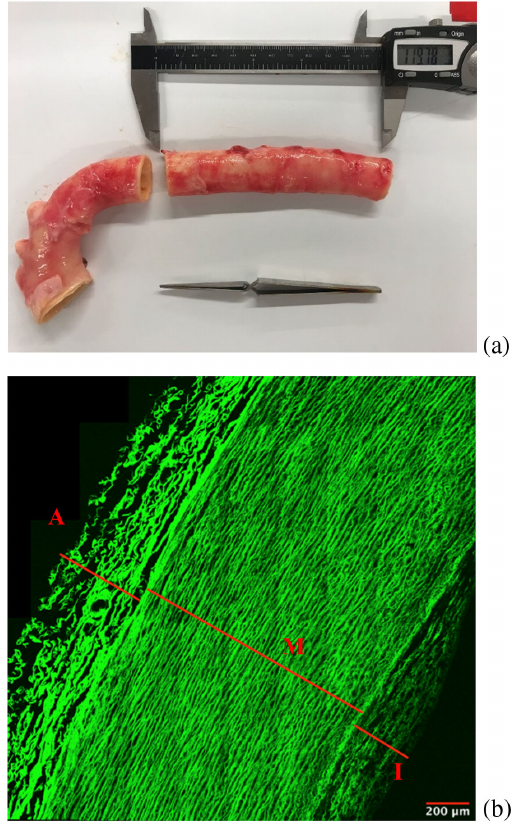
FIG. 2. Specimen preparation and microscopy imaging: (a) tho- racic aorta from donor IX: aortic arch separated from the descending thoracic aorta; the aortic branches and part of the periaortic connective tissue were previously removed; (b) image of the cross-section of the aorta from donor VI, 20 μ m thickness, obtained by nonlinear laser scanning microscopy with second- harmonic generation to show collagen fibers. I: intima, M: media; A: